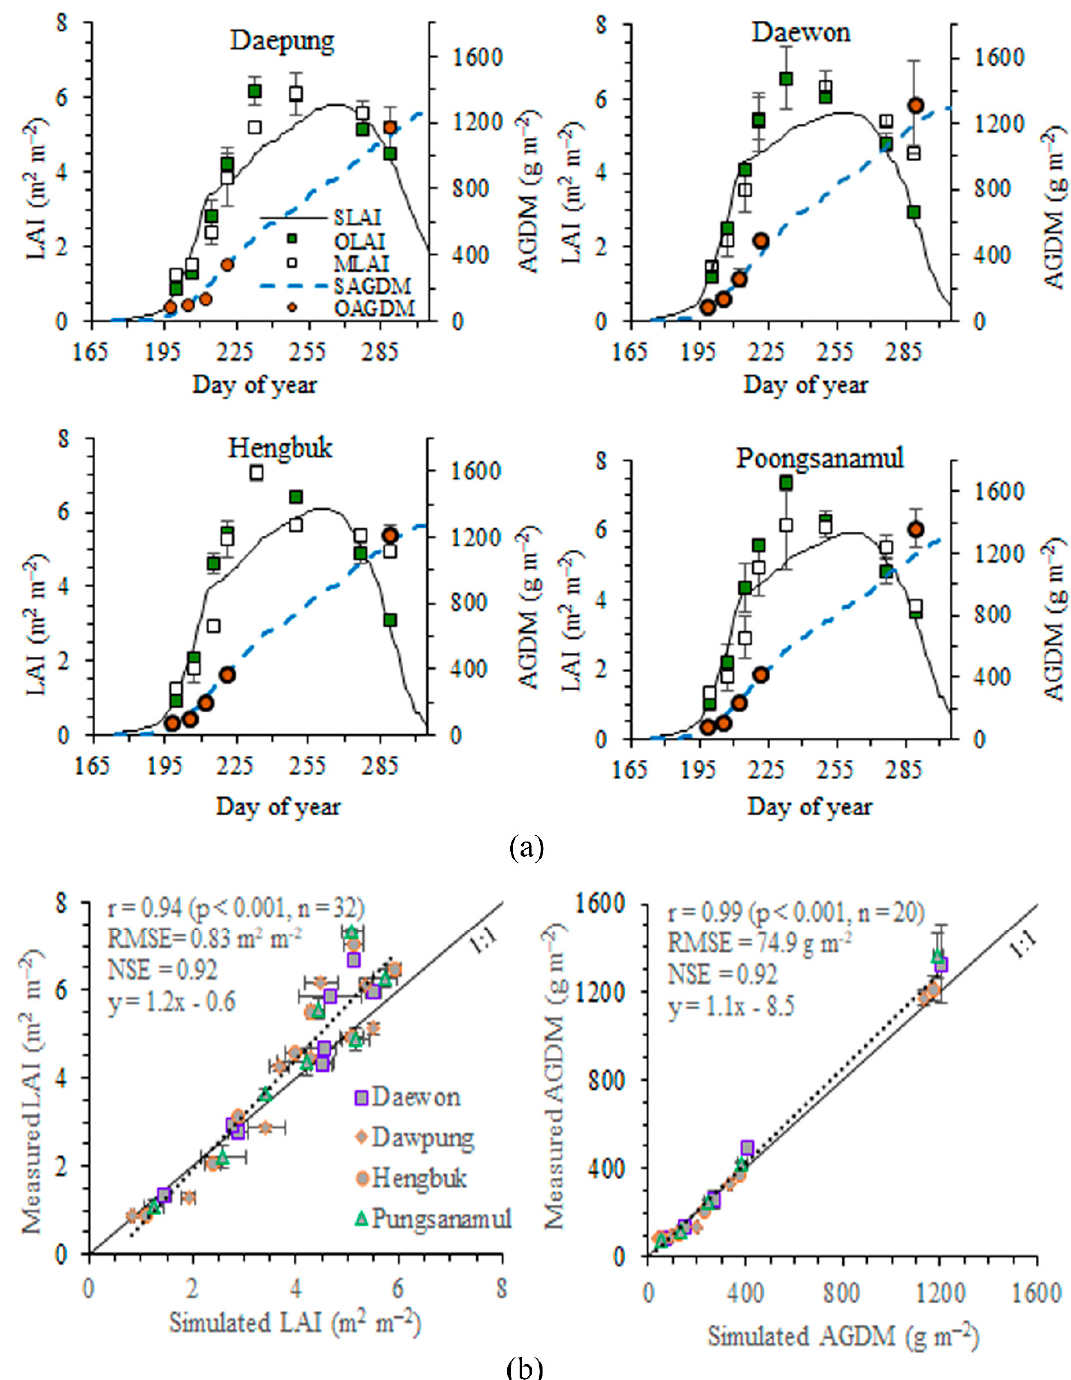
Figure 7. Model validation: Simulated (S) and measured (M), observed (O) values in LAI and S and M values in above-ground dry mass (AGDM) for four soybean cultivars, Daepung, Daewon, Hengbuk, and Poongsan based on the VI input option ( a ) and comparisons between S and M values in LAI and AGDM ( b ). Data were obtained at Chonnam National University, Gwangju, South Korea in 2018. Vertical and horizontal error bars represent ±1 SD of the means values. The solid and dotted lines in the panel ( b ) represent the ratio 1:1 and a linear fit, respectively. NSE, RMSE, and r denote Nash- Sutcliffe efficiency, root mean square error, and Pearson’s correlation coefficient, respectively .